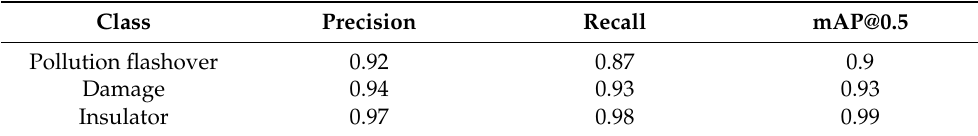
Table 8. Detection effect of the model on each